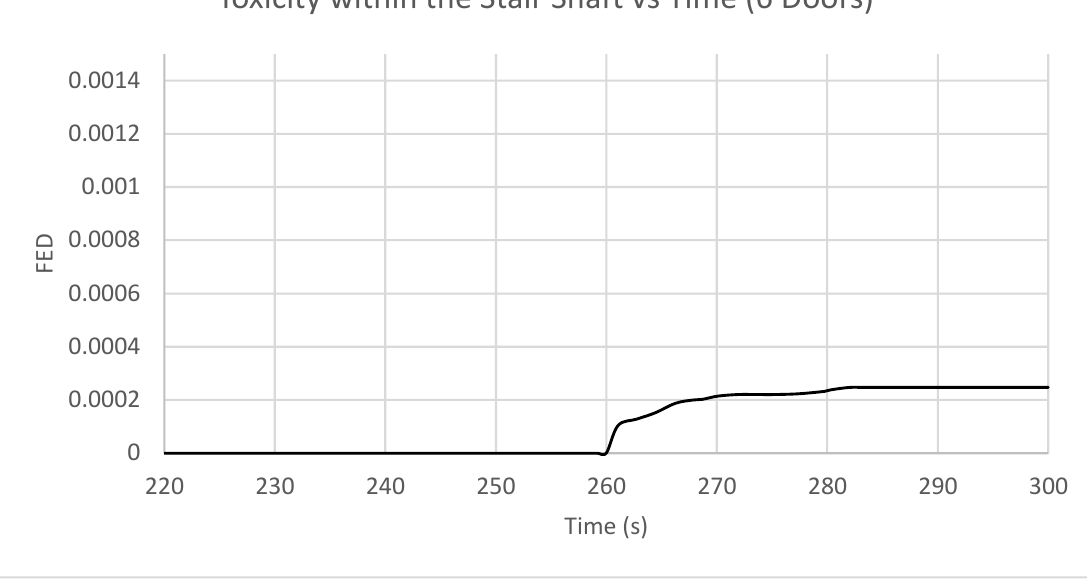
Figure 10. Toxicity within the stair shaft with 6 doors open.